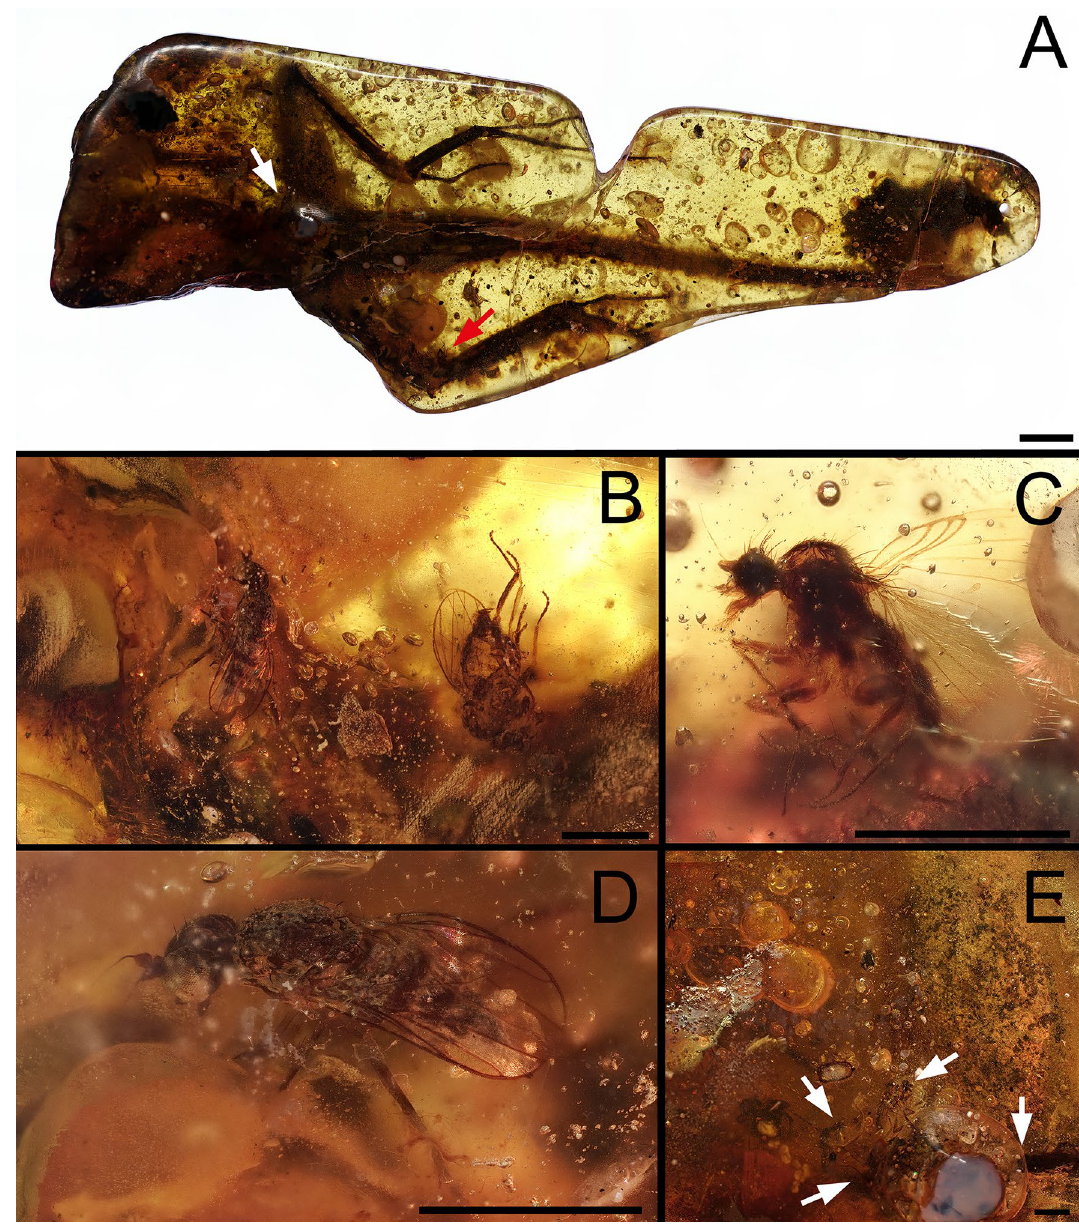
Figure 5. Piece number GRS-Ref-28631 with an incomplete lizard, probably of the family Agamidae. ( A ) Habitus of the lizard (white and red arrows show the place where the flies are located). ( B ) Two Empidoidea. ( C ) One Phoridae. ( D ) One Empidoidea. ( E ) Other Phoridae (white arrows show the position of the flies, which are not easy to observe in this dark amber piece). Scale bars: ( A ) 5 mm, ( B – E ) 1